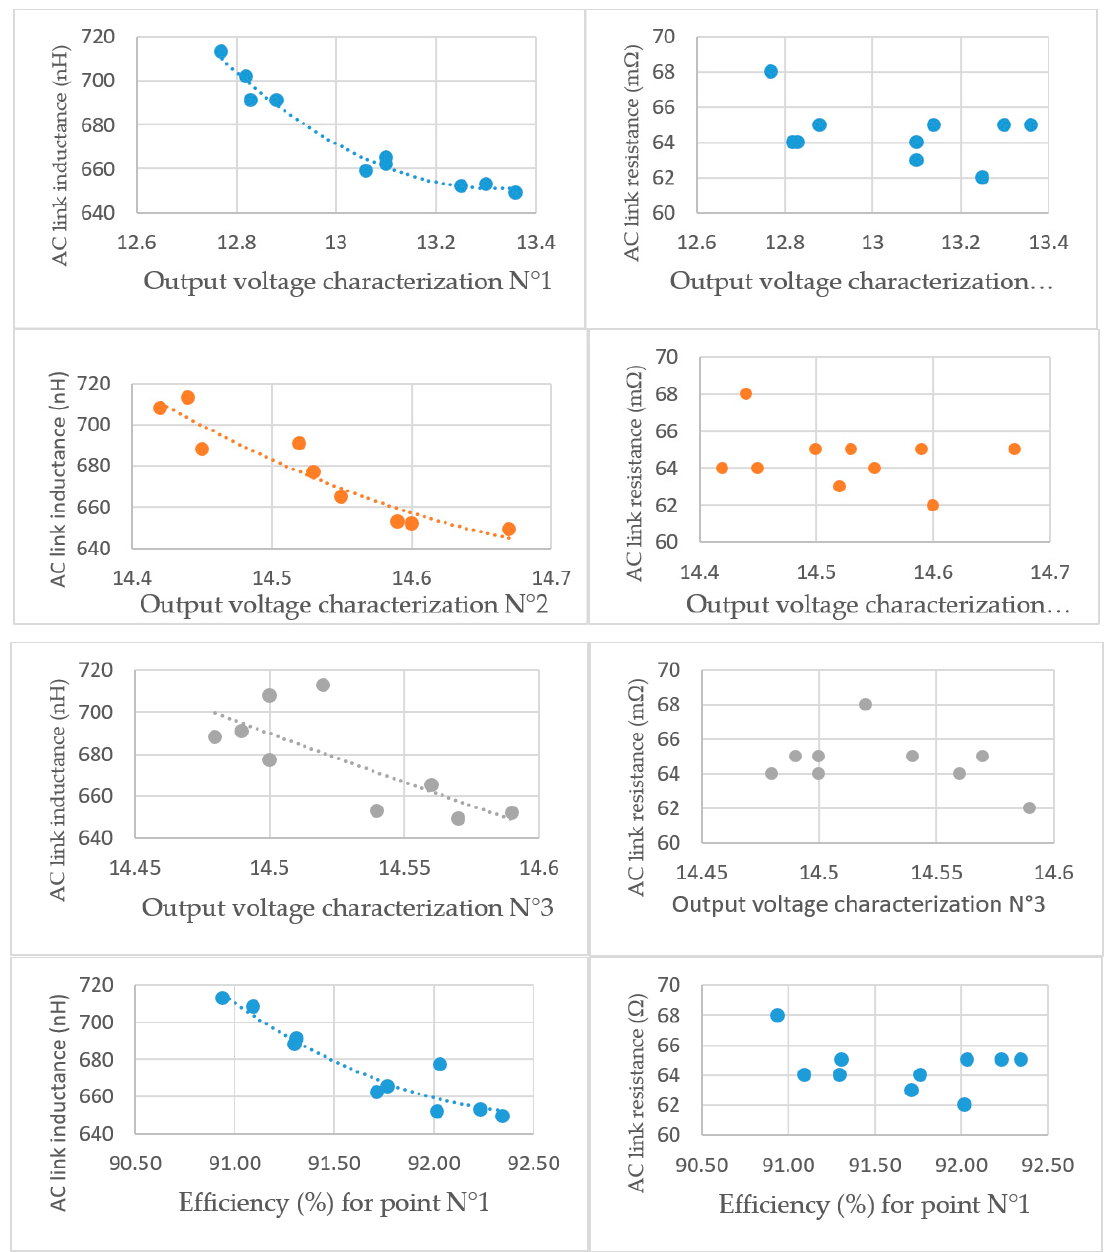
Figure 7. Correlation curves between AC link equivalent inductor value and CSC output voltage and efficiency and equivalent resistor versus output voltage.